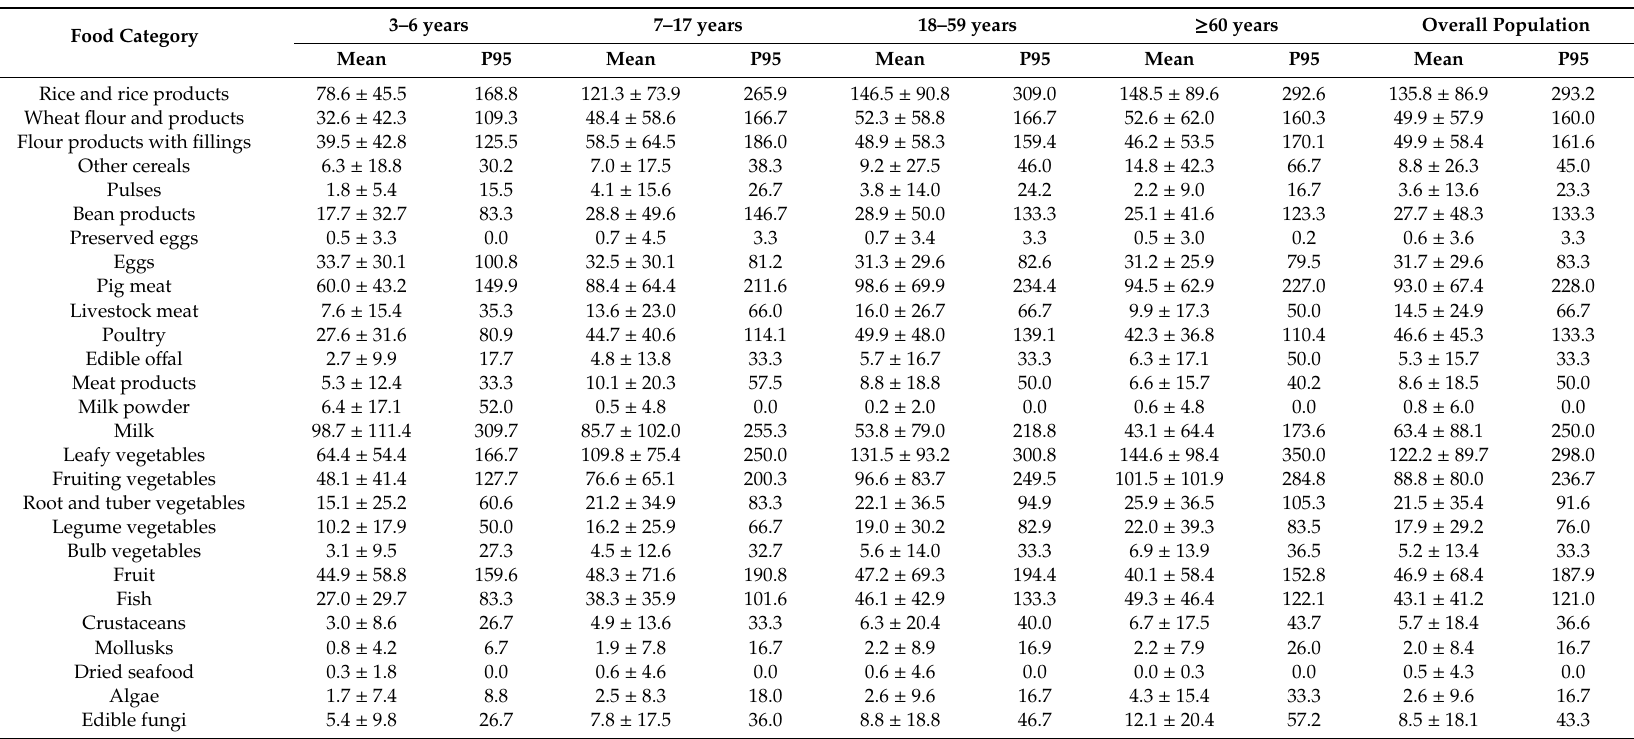
Table A1. Food consumption among Guangzhou residents in 2011 (g /